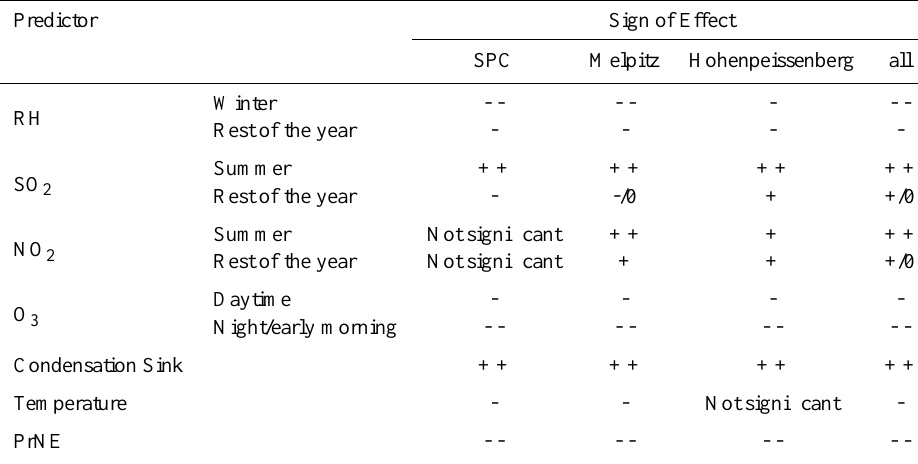
Table 2. Signs and magnitudes of the parameters of the model ( β i + v i ). Minus sign denotes a negative regression effect on N 50 and plus sign denotes a positive effect and the number of signs describes the magnitude of the effect. Predictor SPC Winter - RH